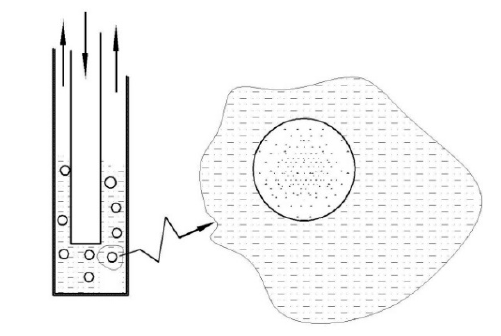
Figure 3. Schematic of syngas conditioning using molten